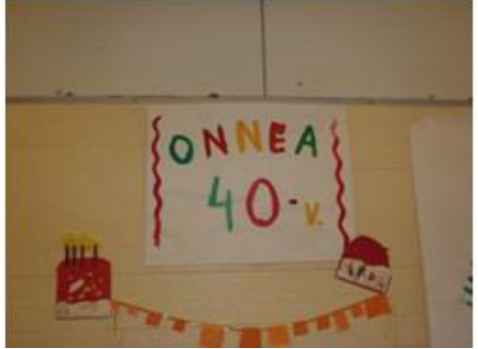
Figure 1. I can do a similar piece by myself. Extract